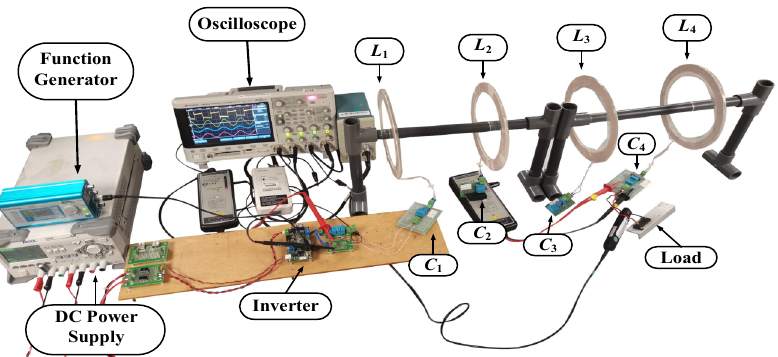
Figure 7. Schematic of the experimental setup.